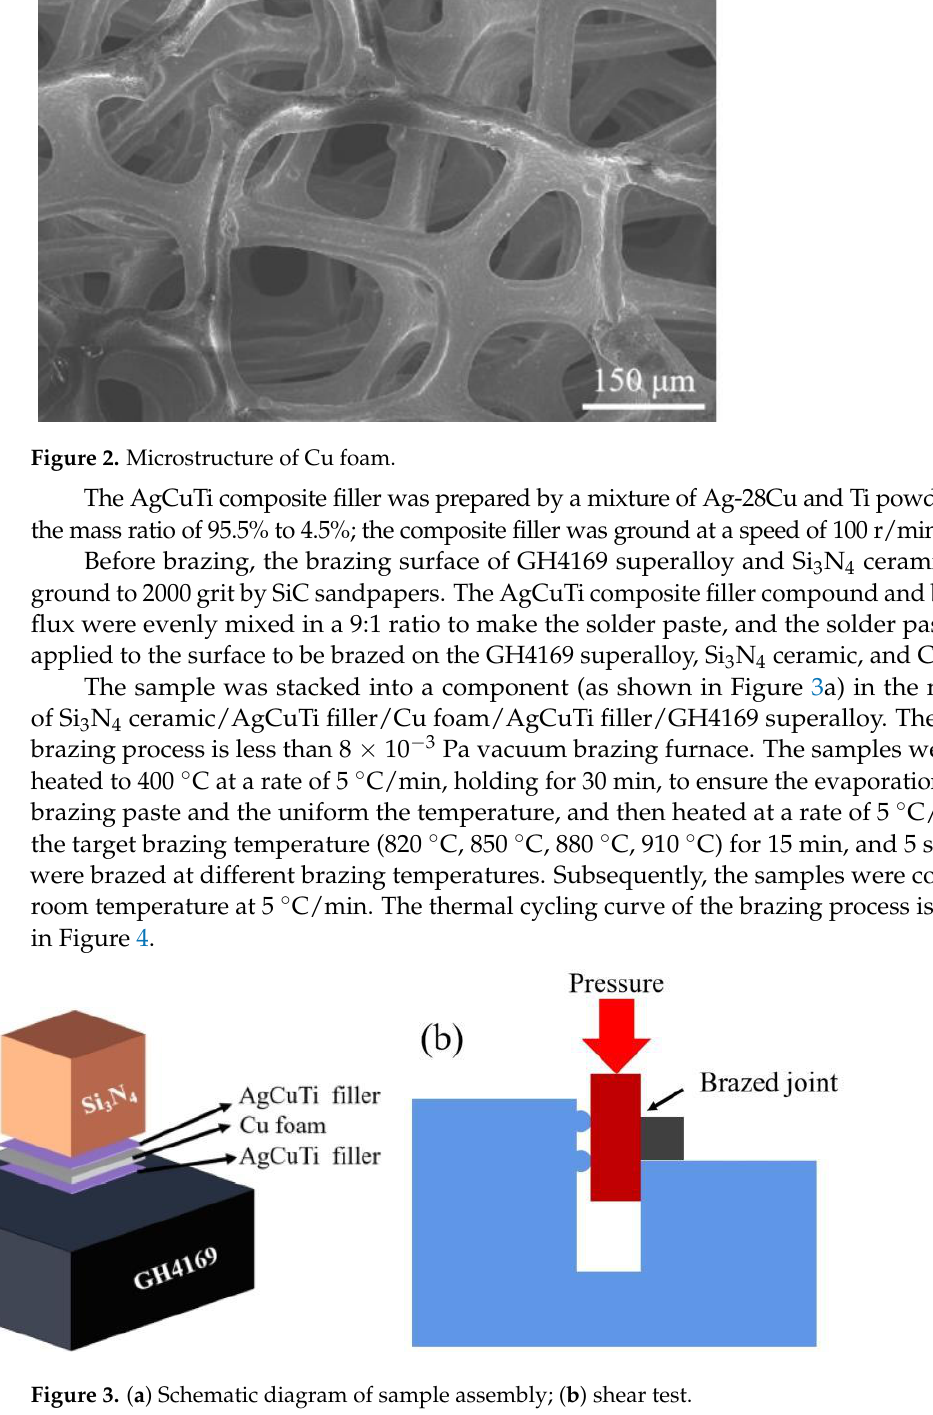
Figure 1. Microstructure of GH4169 superalloy.